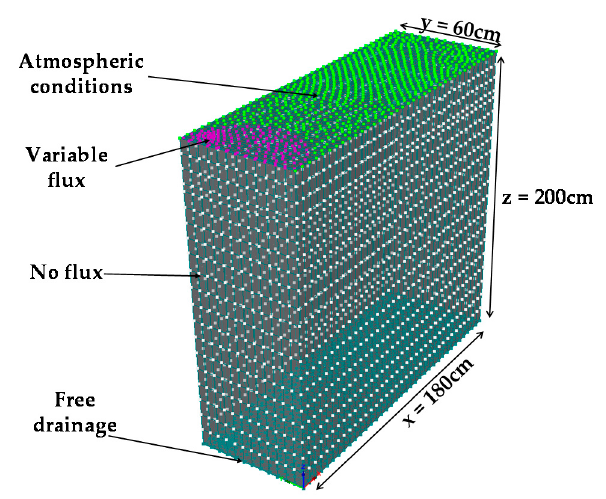
Figure 3. Flow domain and boundary conditions used in the HYDRUS-3D simulations.